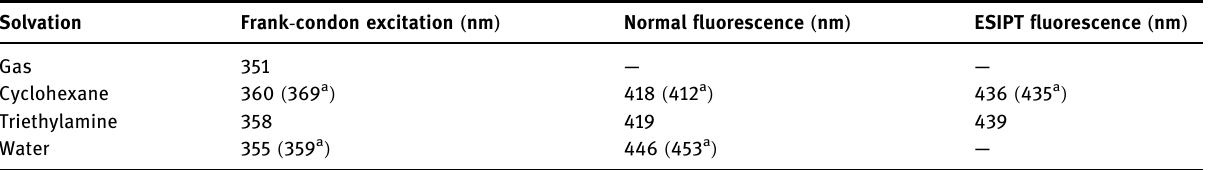
Table 3: The excitation energy, normal fl uorescence and ESIPT fl uorescence in the various surroundings